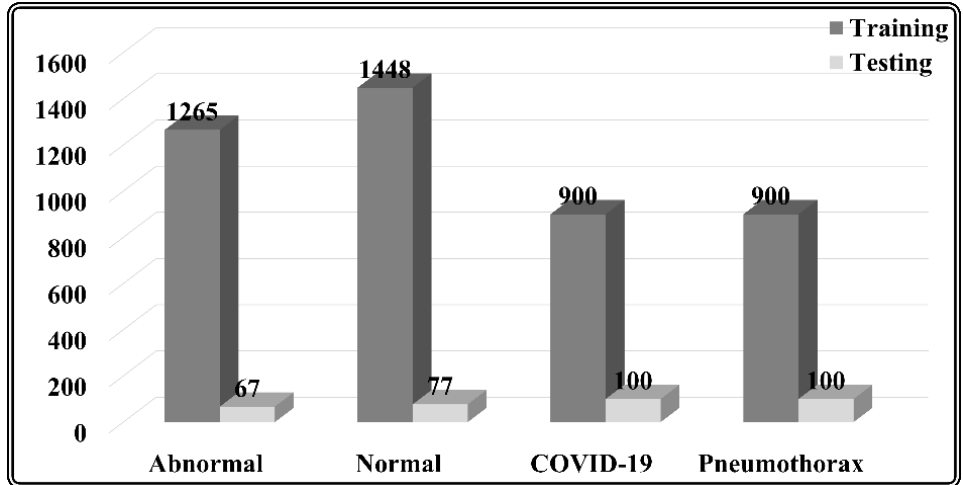
Figure 2. Dataset Distribution.